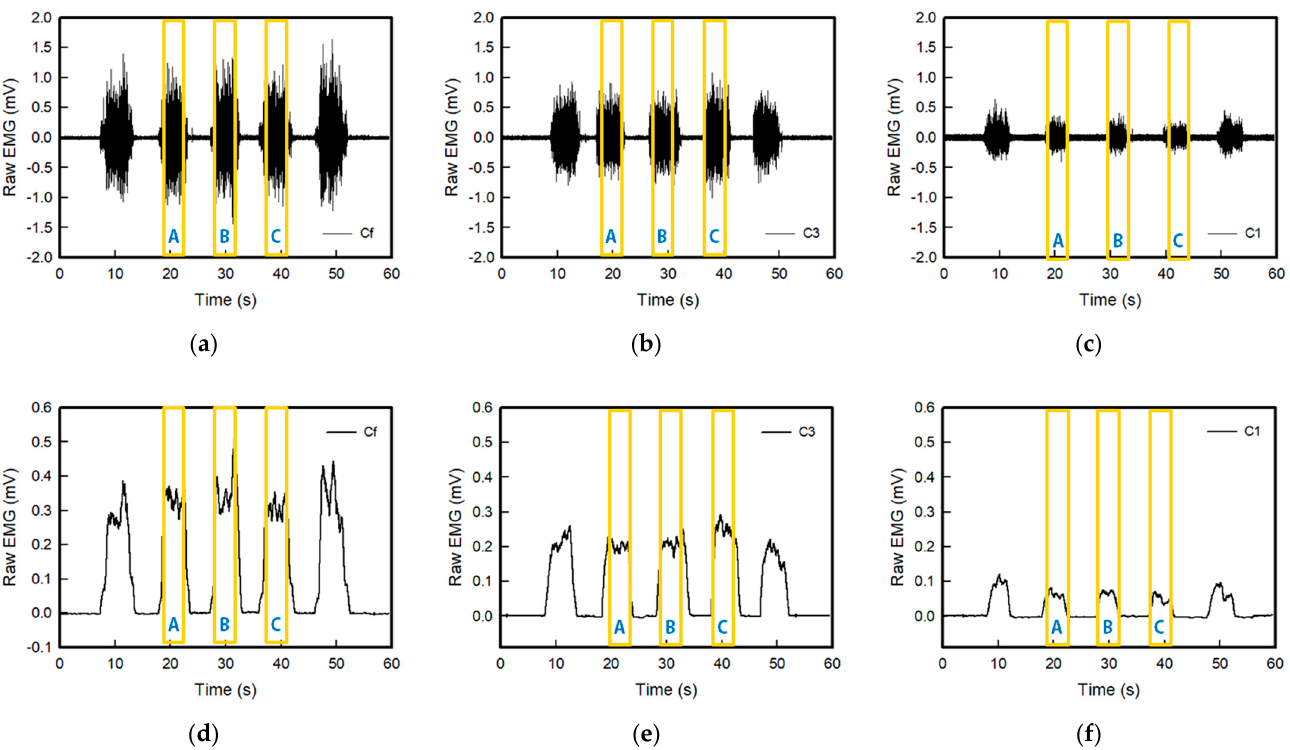
Figure 8. Graph of raw sEMG signals obtained via ( a ) Cf, ( b ) C3, and ( c ) C1 and filtered (20–500 Hz) in analog and full-wave of the sEMG signal of ( d ) Cf, ( e ) C3, and ( f ) C1, respectively; Here, the values of sections A, B, and C in the yellow box were used for EMG signal measurement and analysis.